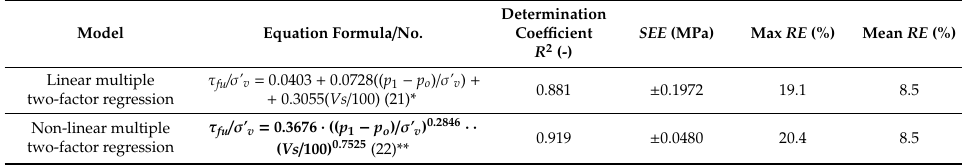
Table 7. Comparison of the analyzed two-factor regression